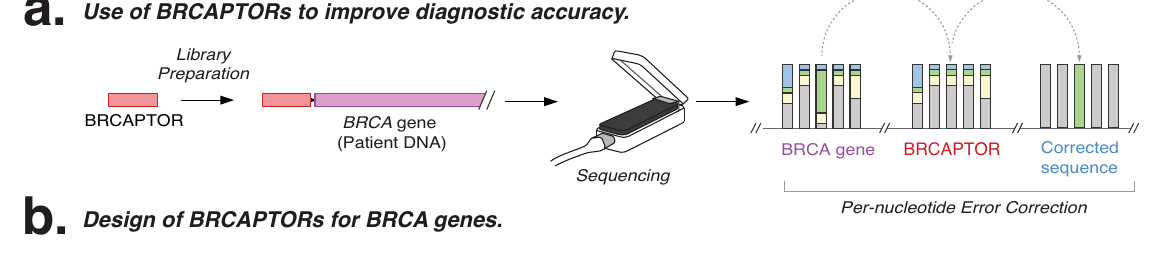
correspondinggenesequenceswithinNA12878humanDNAsequence,BRCAPTOR, and error-corrected sequence. d Scatter plot indicates the correlation between sequencing errors in NA12878 human DNA relative to BRCAPTORs. e Cumulative frequency distributionshowsthesequencing errorpro fi leofNA12878humanDNA sequence,BRCAPTOR,anderror-correctedsequence.Sourcedataareprovidedasa Source Data fi